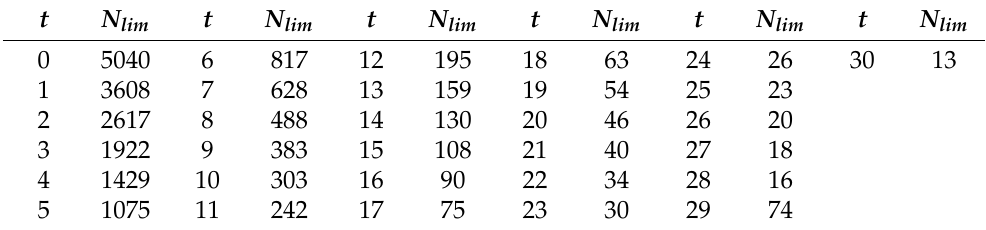
Table 2. Dependence of N lim for M = 7 and ∆ = 0.04 when t = 0,1,2, . . .